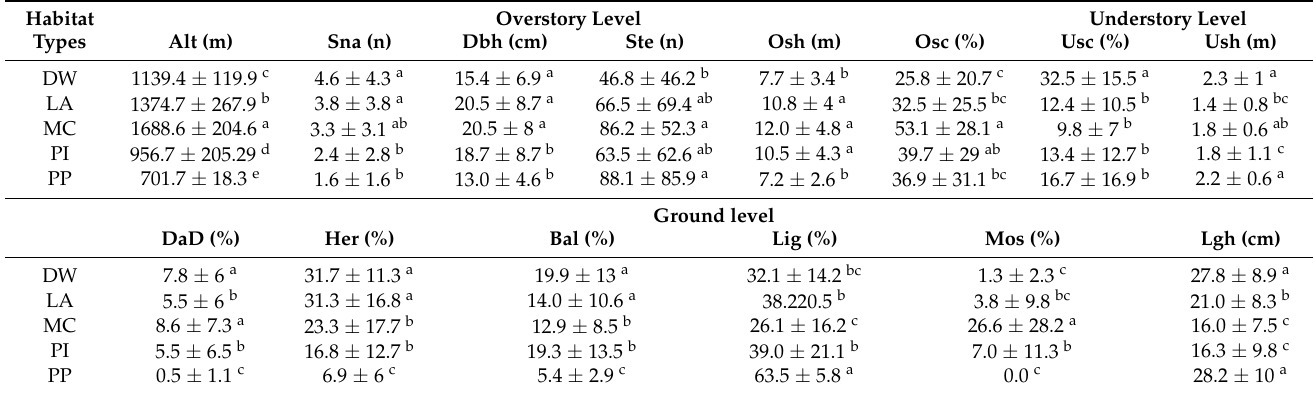
Table 5. Results of one-way analysis of variance (ANOVA) with Tukey’s HSD test for environmental variables (mean ± SD) among different forest habitat types in the Khentii